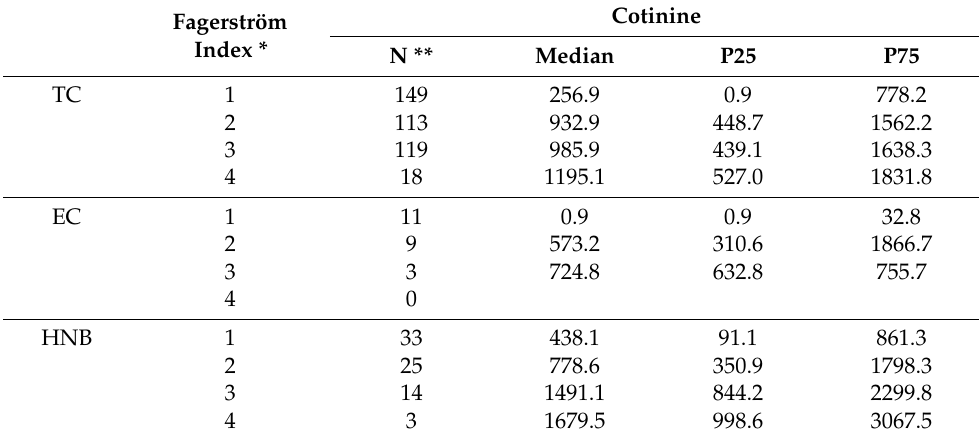
Table 4. Frequency of cigarette smoking evaluated by the Fagerström test for nicotine